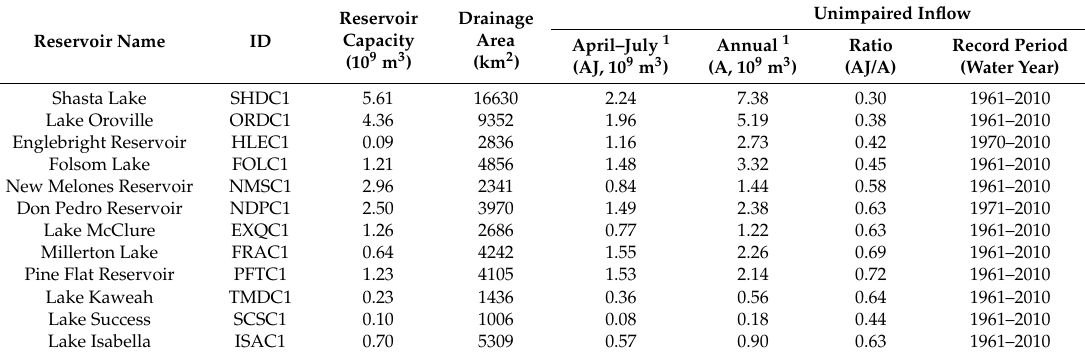
Figure 2. ( a ) Mean monthly precipitation and ( b ) mean monthly temperature of the study forecast groups for October (O), November (N), December (D), January (J), February (F), March (M), April (A), May (M), June (J), July (J), August (A), and September (S). Period of record is from water year 1949–2010. Table 2. General information of study reservoirs.